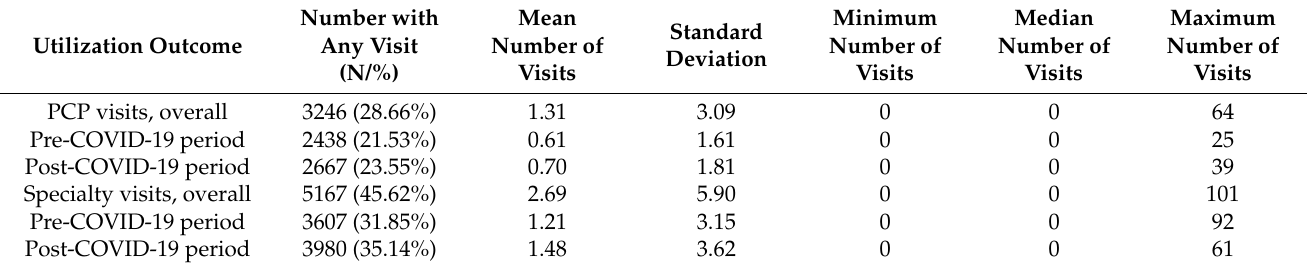
Table 2. PCP and specialty visit utilization overall and by pre- and post-COVID-19 diagnosis